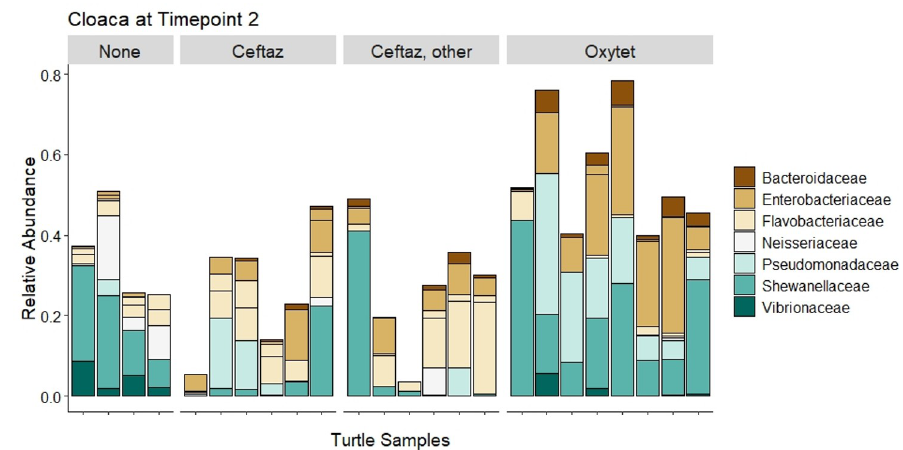
Fig 8. ASVs of cloacal samples at timepoint 2. Relative abundance of ASVs (colored by family) that significantly contribute to the differences between antibiotic type of cloacal samples while in rehab.